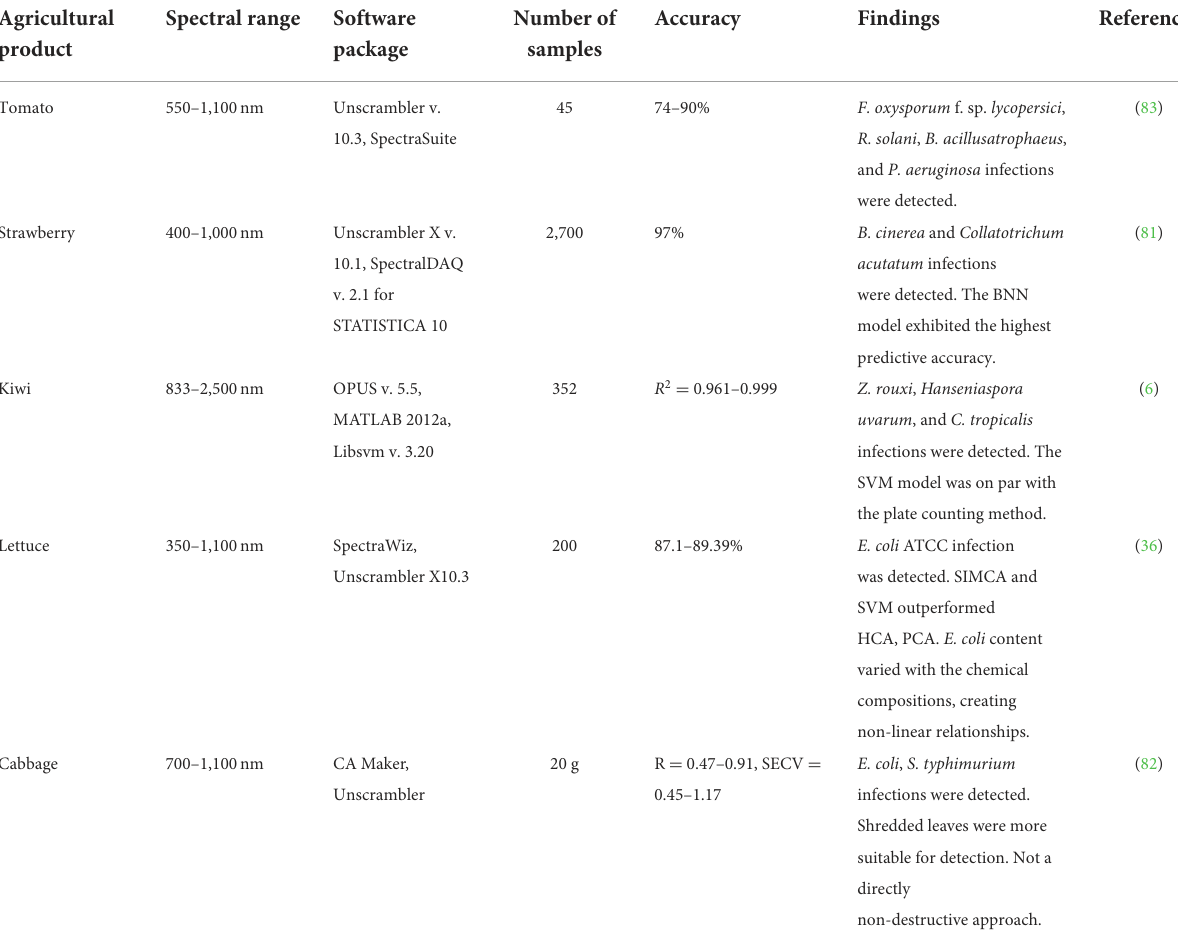
TABLE 6 Summary of NIRS applications for the detection of target microbial/fungus contamination in agricultural products.